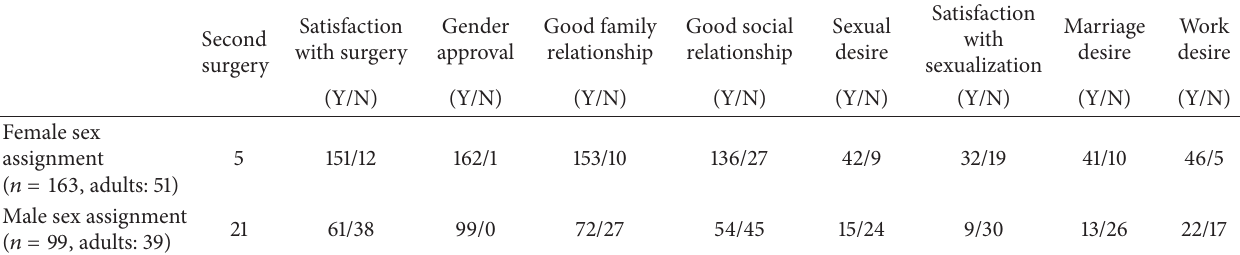
Table 2: Surgical outcome and psychoscial adaption in sex assignment of female and male